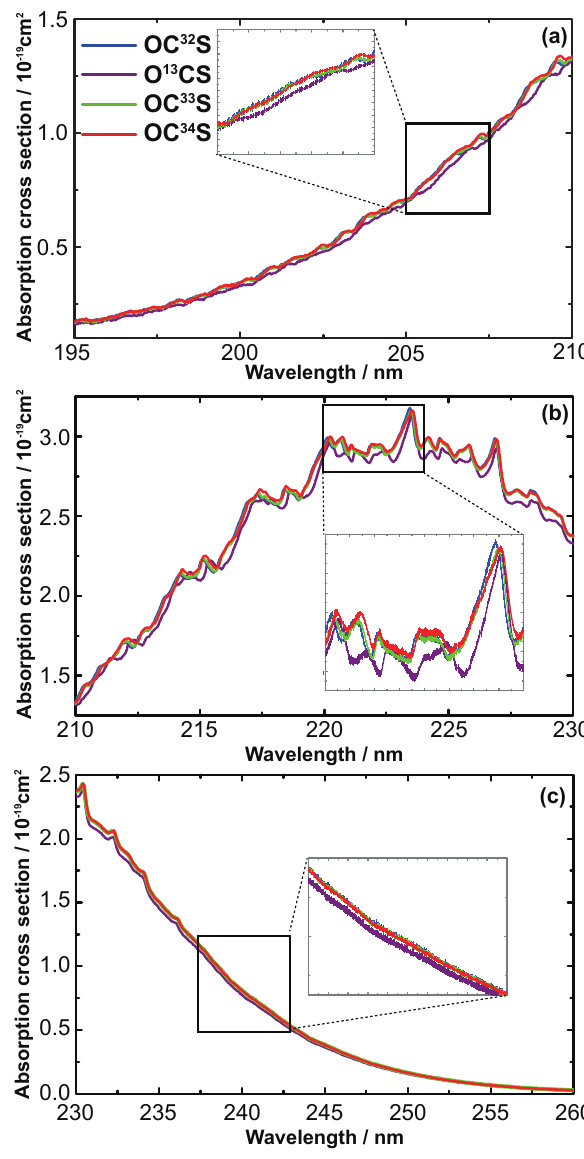
Fig. 2. Comparison of absorption cross sections measured at 0.1nm resolution and 0.02nm step size for isotopically enriched samples of OC 32 S, OC 33 S, OC 34 S, and O 13 CS divided in three energy ranges; 195–210nm (a) , 210–230nm (b) and 230–260nm (c)